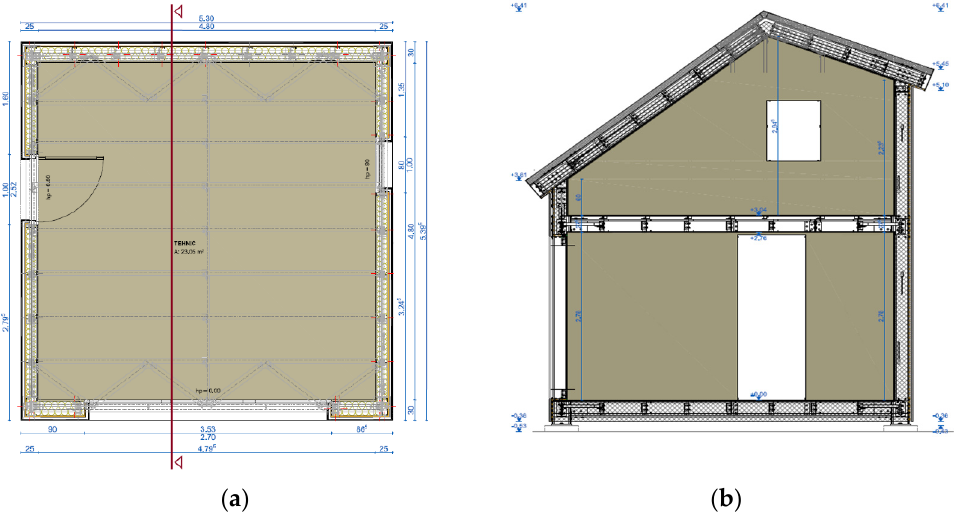
Figure 8. Detailed view of the building envelope: ( a ) ground floor layout; ( b ) vertical cross-section. Based on them, the more thermally permeable junctions were identified, as illustrated in Figure 9. The main constructive details were defined, and the geometrical models were created following each layer and component, their dimensions and thermal conductivities. At the same time, the modelling lengths, as well as the boundary conditions, were set.